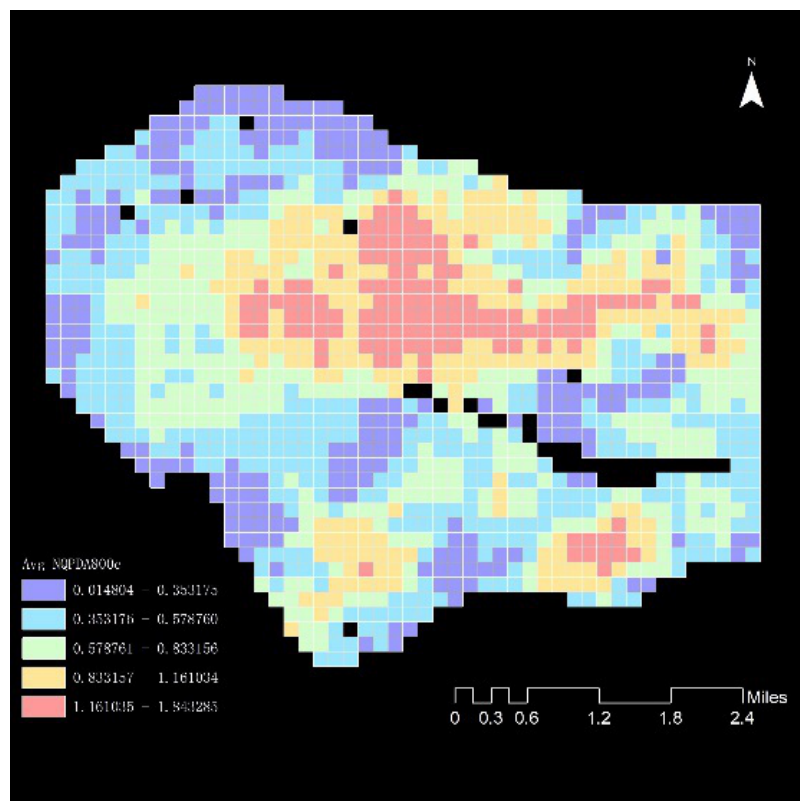
Fig. 5 Fishing net graph of the regional closeness of 800m